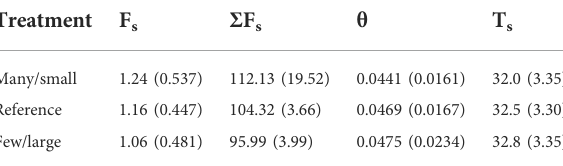
TABLE 2 Mean and standard deviation (parentheses) of seasonal average daily mean soil CO 2 ef fl ux (F s ), soil moisture ( θ ), soil temperature (T s ), and seasonal total F s ( Σ F s ) for the three levels of rainfall